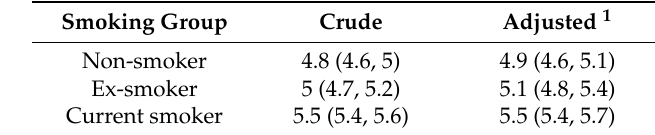
Table 2. Financial stress scores (mean, 95% Confidence Interval, CI) for non-, ex-, and current smokers.